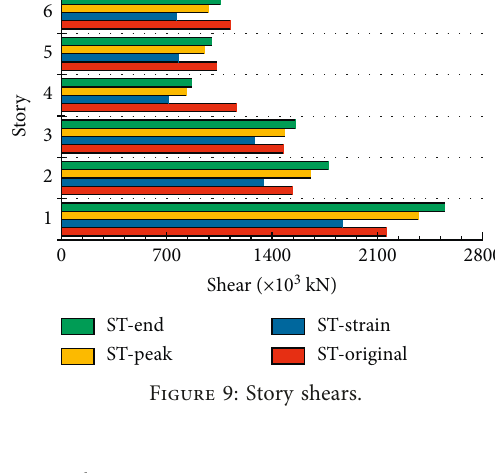
Figure 9: Story shears.